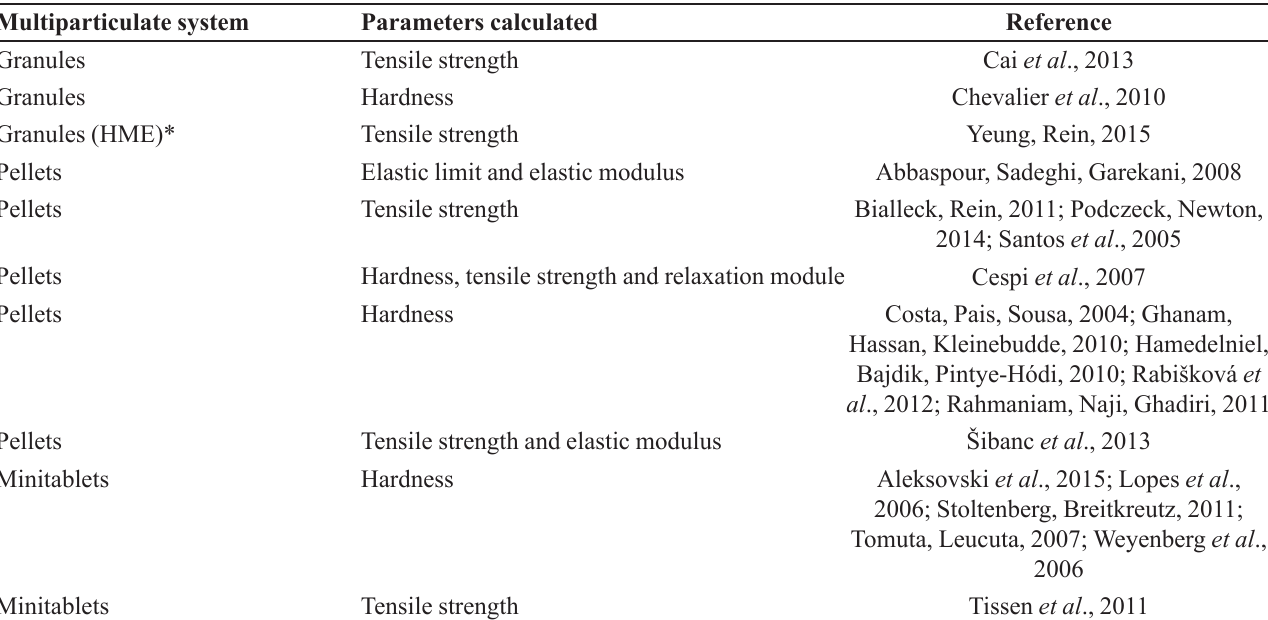
TABLE VIII - Strength properties evaluated in multiparticulate systems Multiparticulate